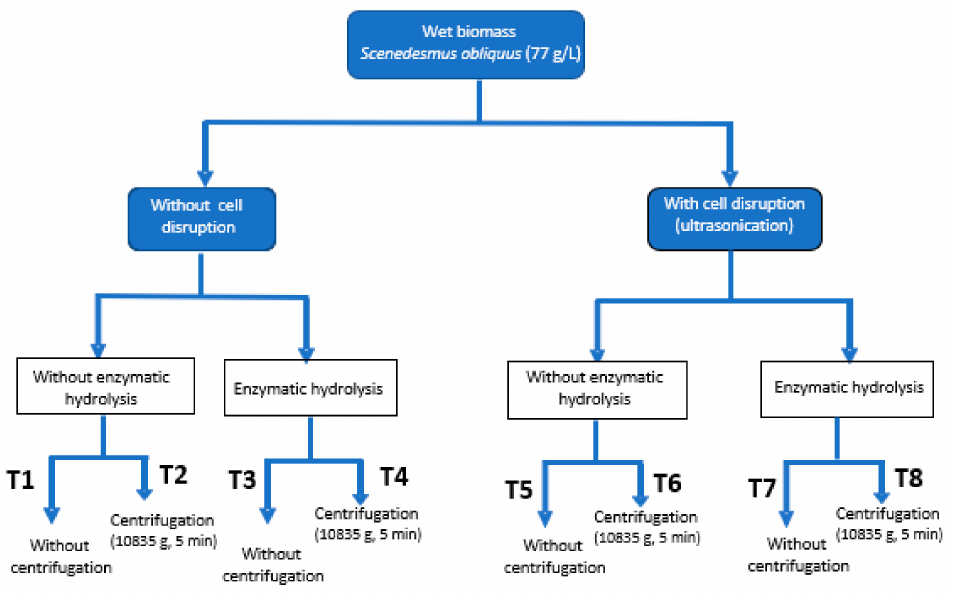
Figure 1. Downstream processing of the wet microalgal biomass (cell rupture by ultrasounds, enzymatic hydrolysis and centrifugation). For each treatment di ff erent concentrations were tested (0.1, 0.5 and 2 g / L depending on the